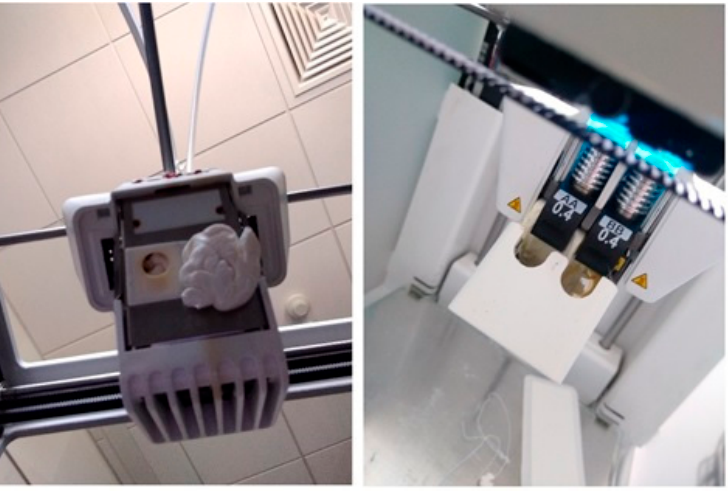
Figure 3. Printer’s nozzle damaged by a filament which did not adhere due to warping.